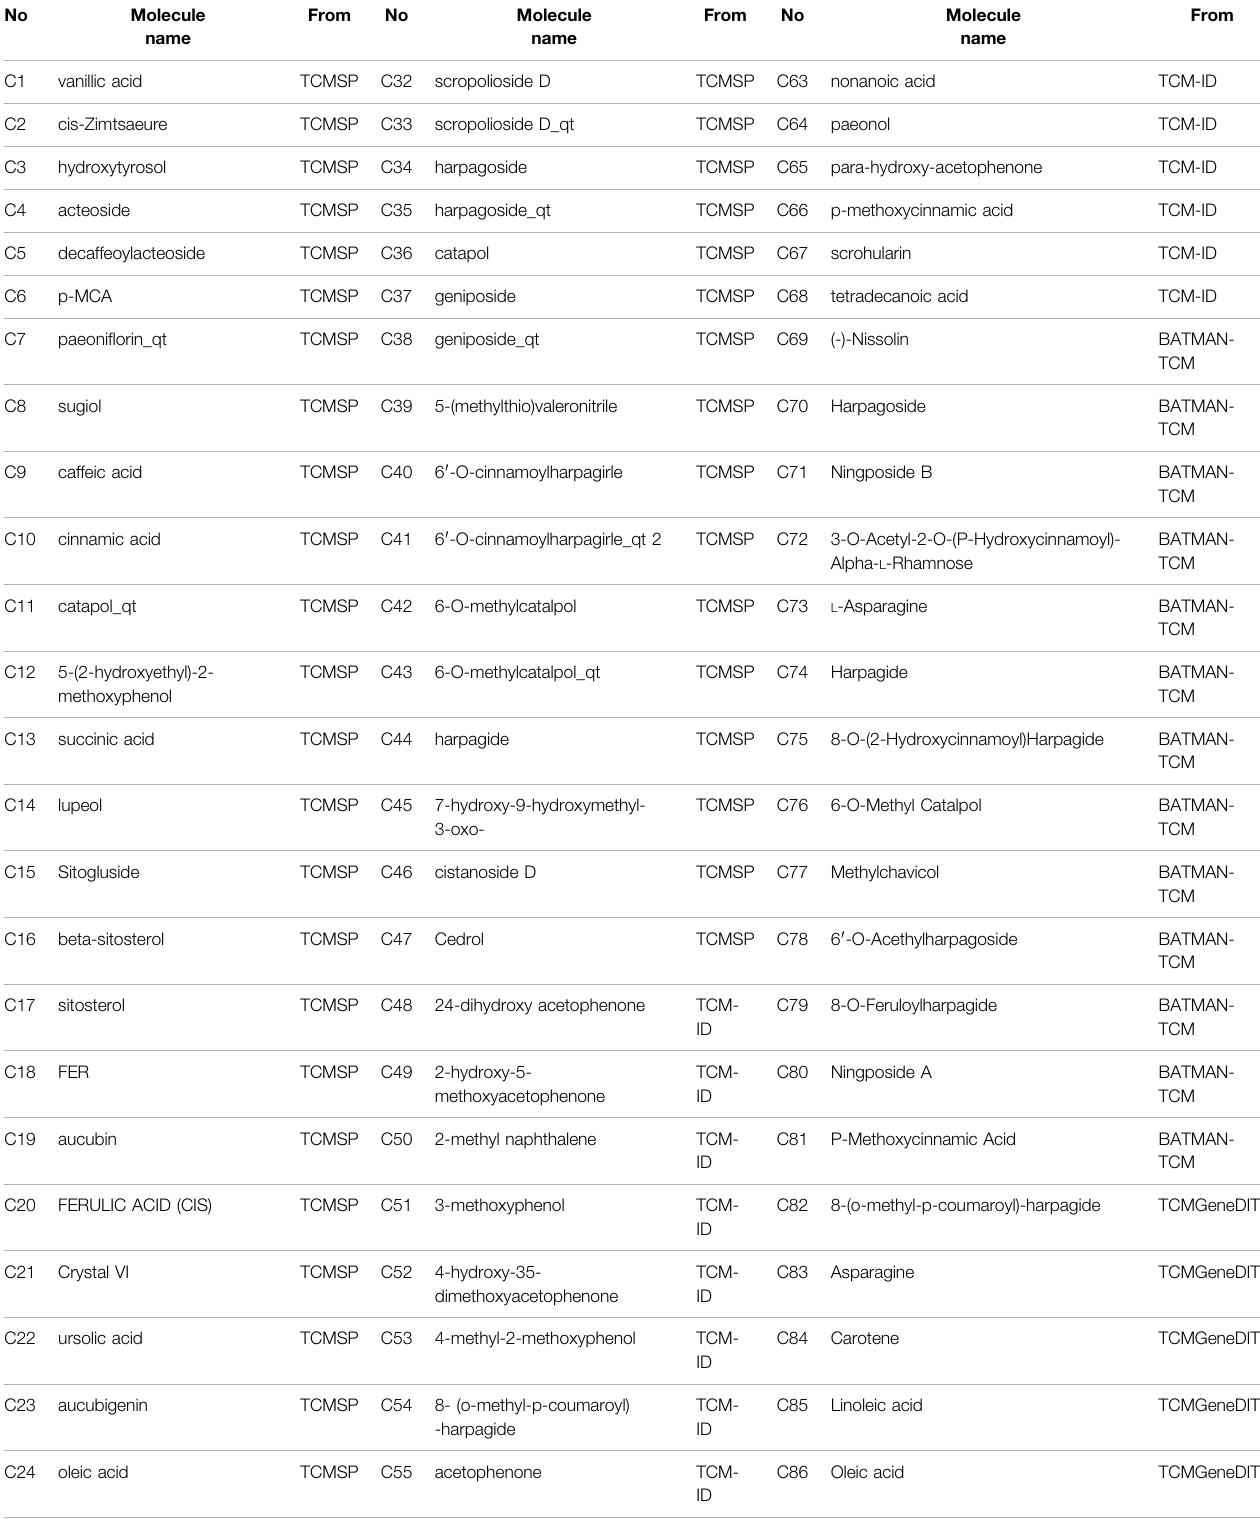
TABLE 4 | Chemical composition of R. Scrophulariaceae in different